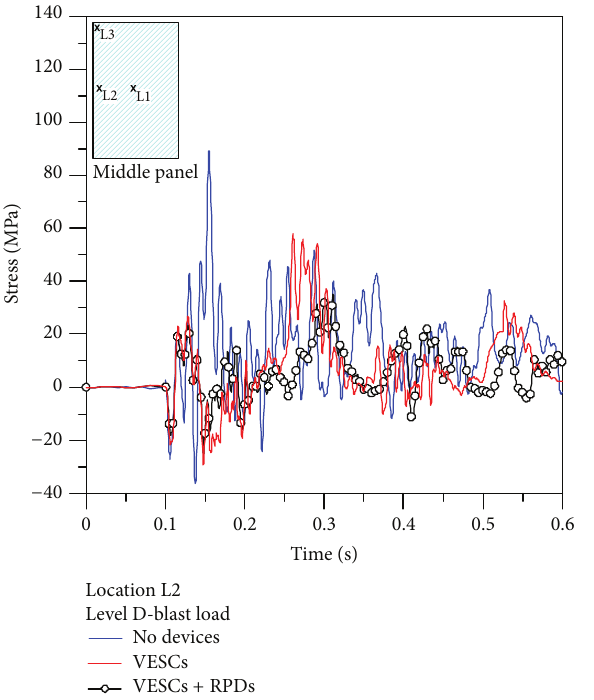
Figure 8: Tensile stresses in the middle glass panel, as a function of time (ABAQUS). Location L2.